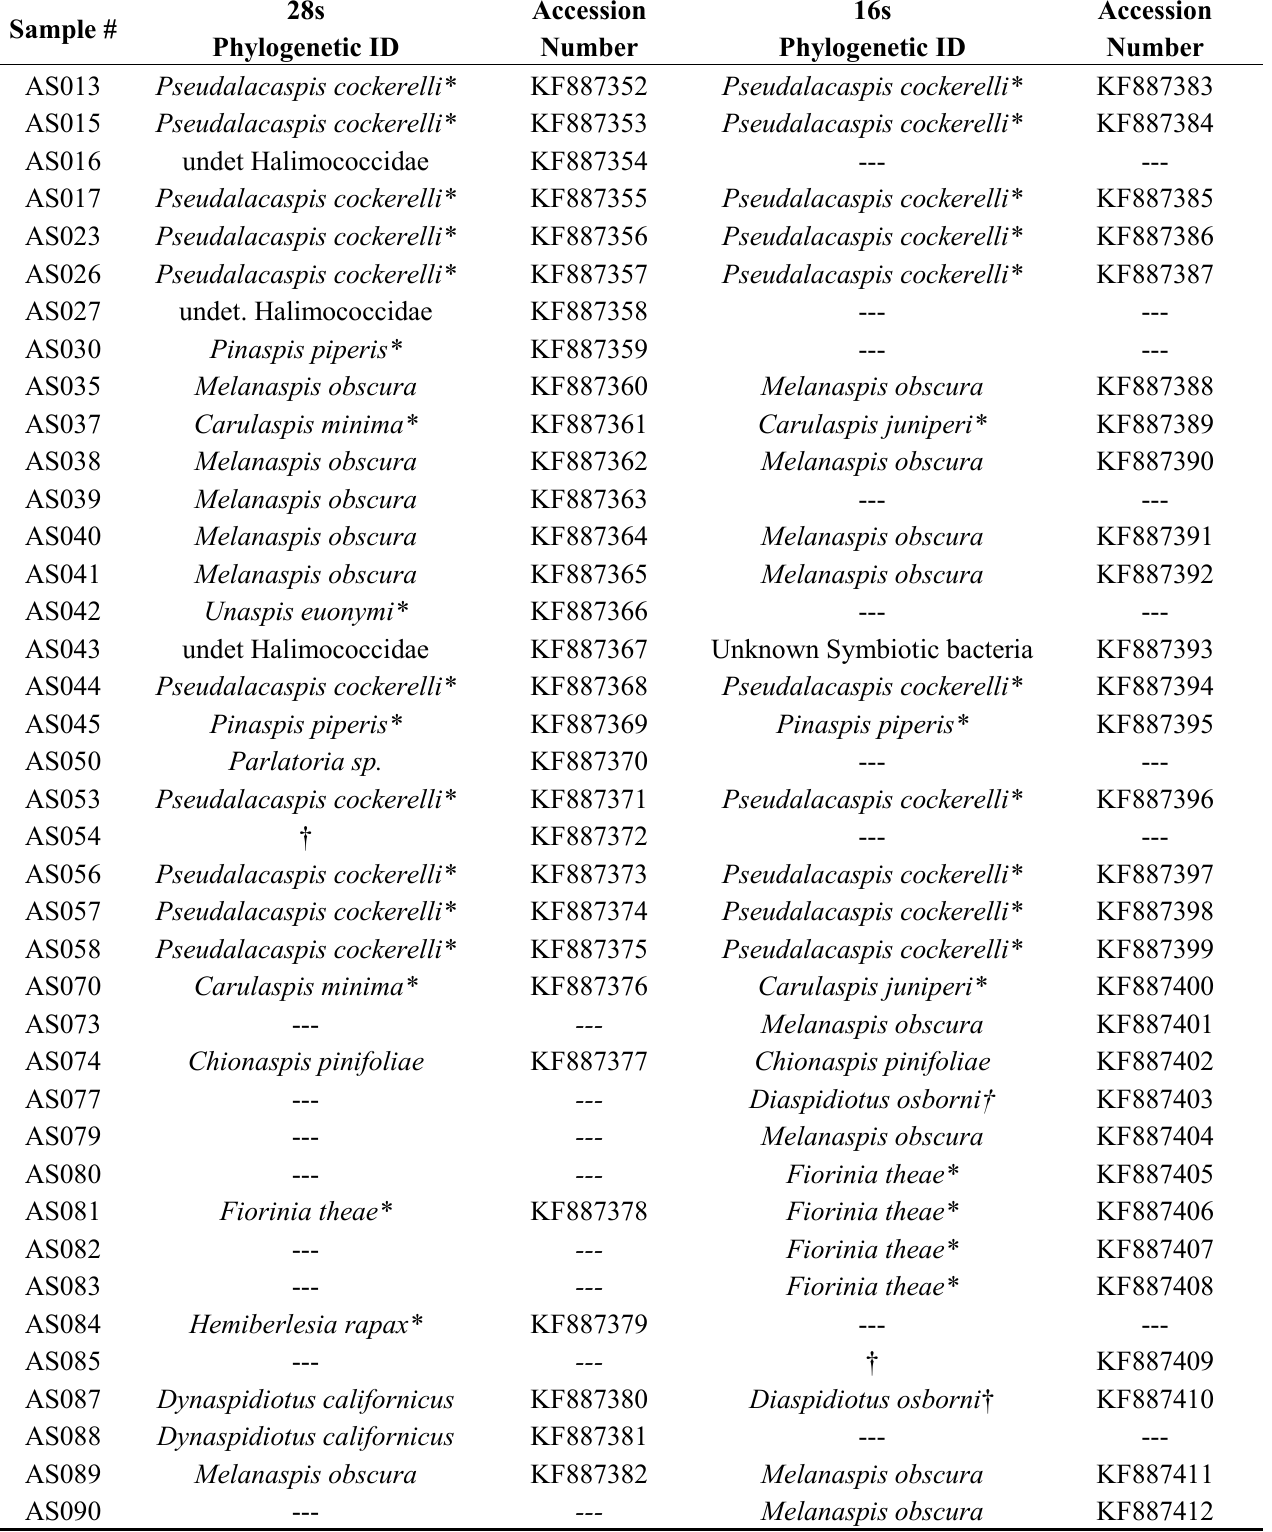
Table 1. Invasive status of original specimens based on sequence similarity to Genbank sequences. Invasive status was determined according to Miller et al. , 2005 [10]. An asterisk * indicates invasive status and a cross † indicates unknown invasive status. Dashed lines indicate no sequences were obtained for that particular specimen. For 16s